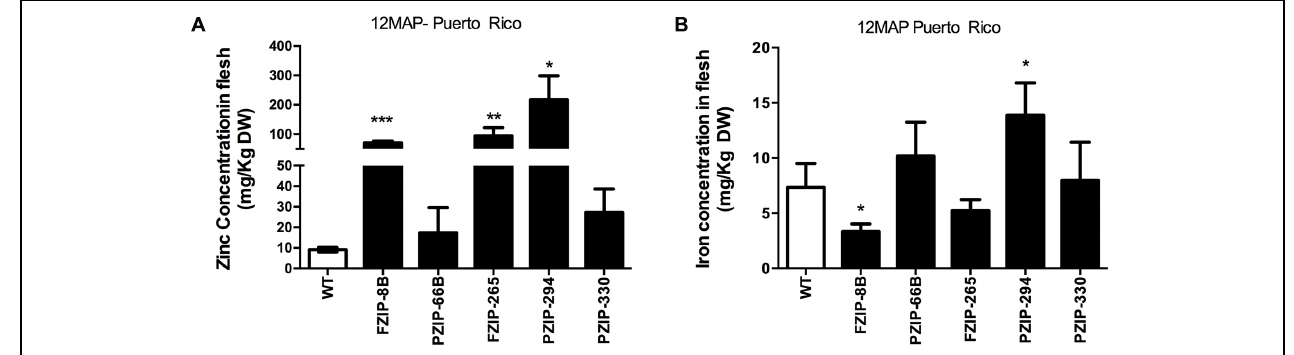
FIGURE 6 | (A) Zinc and (B) iron concentration in flesh of five independent replicated plots, error bars indicate SD. Unpaired t -test comparison wild type vs. transgenic PAT:At ZIP1 (PZIP) and FMV:At ZIP1 (FZIP) events after 12 months of transgenic event. ∗ P < 0.05, ∗∗ P < 0.01, ∗∗∗ P < 0.001. MAP, months after growth in fields at Puerto Rico. Data represent the mean zinc content of three planting. FZIP denotes FMV:ZIP1 lines, PZIP denotes PAT:ZIP1 lines. TABLE 2 | 65 Zn uptake in cassava transgenic lines. Partition Quotient (PQ) Root Lower stem Upper stem Upper leaves Top